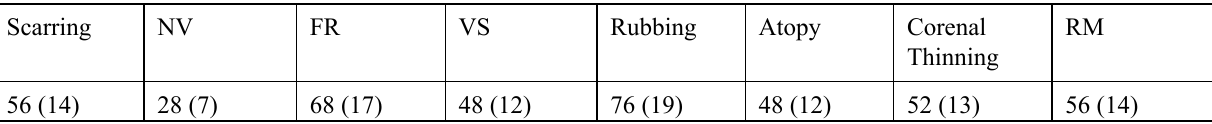
Table 2 . The number of patients presenting with the relevant characteristic is shown here. The total number of patients is 25. The following characteristics are noted: scarring, increased visibility of corneal nerves (NV), Fleischer’s ring (FR), Vogt’s striae (VS), rubbing, atopy, obvious corneal thinning and refractive measures (RM, patients who could not produce any refractive measures). Data are given as percentage and number of patients ( n